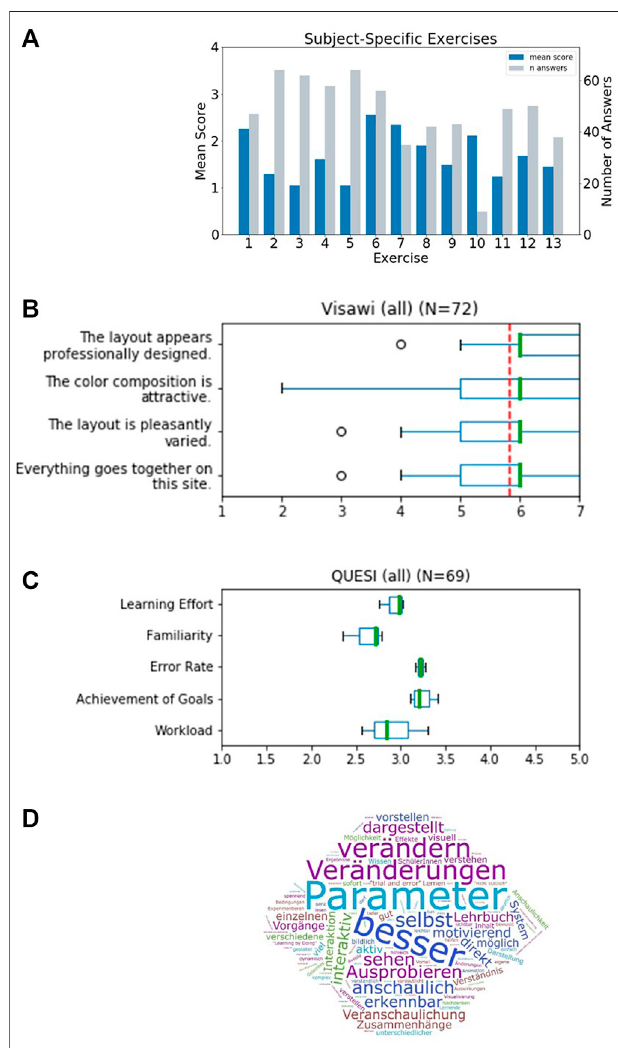
FIGURE 6 | Results of a survey for undergraduate students that worked with Alvin inaphysiologylabcourse. (A) Evaluationofthirteensubject-speci fi c exercises. Responses were scored 1 - correct, 2 - partially correct (e.g., subsequent faults), 3 - unclear to 4 - incorrect. The mean score for every exercisewasdetermined.Theindividualexerciseswere answered bydifferent numbers of participants (grey bars). (B) The standardized Visawi-s survey (Moshagen and Thielsch, 2021) addresses design features. The 72 participants rated from 1 (strongly disagree) to 7 (strongly agree). The mean score over all four categories was 5.8 (red, dashed line). (C) Results on usability from the standardized survey QUESI (Hurtienne and Naumann, 2010). Five subscales are assessed, with higher scores obtained the more intuitive the use of the system was perceived to be. The mean overall QUESI scorefrom69formswas2.98. (D) Participantswereasked “ whichbene fi tsdo you see in this system compared to a traditional text book? “ . A frequency analysis on the answers was performed. The most recurrent terms were (translated from German): “ parameter ” , “ better ” , “ modi fi y ” , “ changes ” , “ by oneself ” , “ illustrative ” , “ testing ” , “ see ” , “ illustrated ” , “ apparent ” , “ interactive ” and “ immediate ”